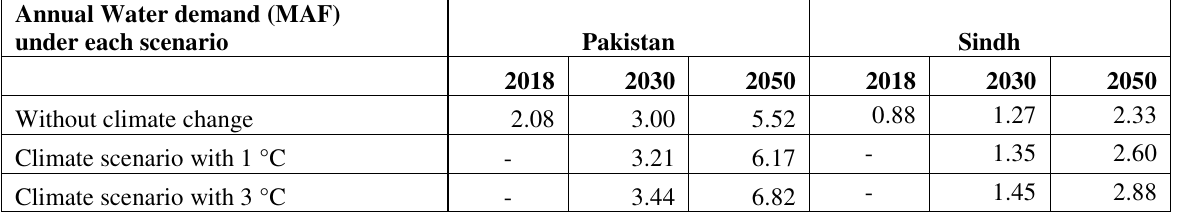
Table 4: Agricultural Water Demand in Pakistan and Sindh Annual Water demand (MAF) under each scenario Without climate change Climate scenario with 1 °C